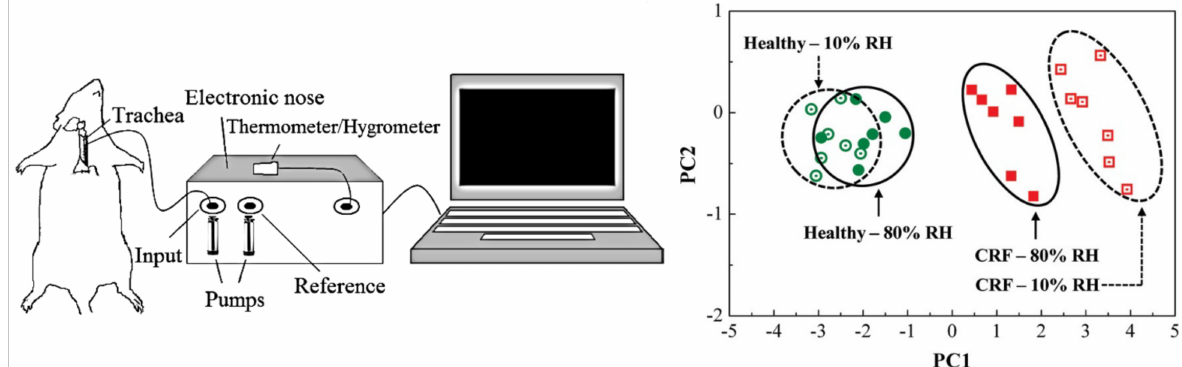
Figure 9. ( Left side ), schematic illustration of the experimental system used to collect breath from rats; ( right side ), PCA results on the response collected by the 10 sensors array upon exposure to the breath of healthy and CRF rats (with 80% RH), before and after dehumidifying the breath (80% RH vs. 10% RH). Better discrimination is obtained for lower humidity value. Reproduced with permission from [49]. Copyright (2009) American Chemical